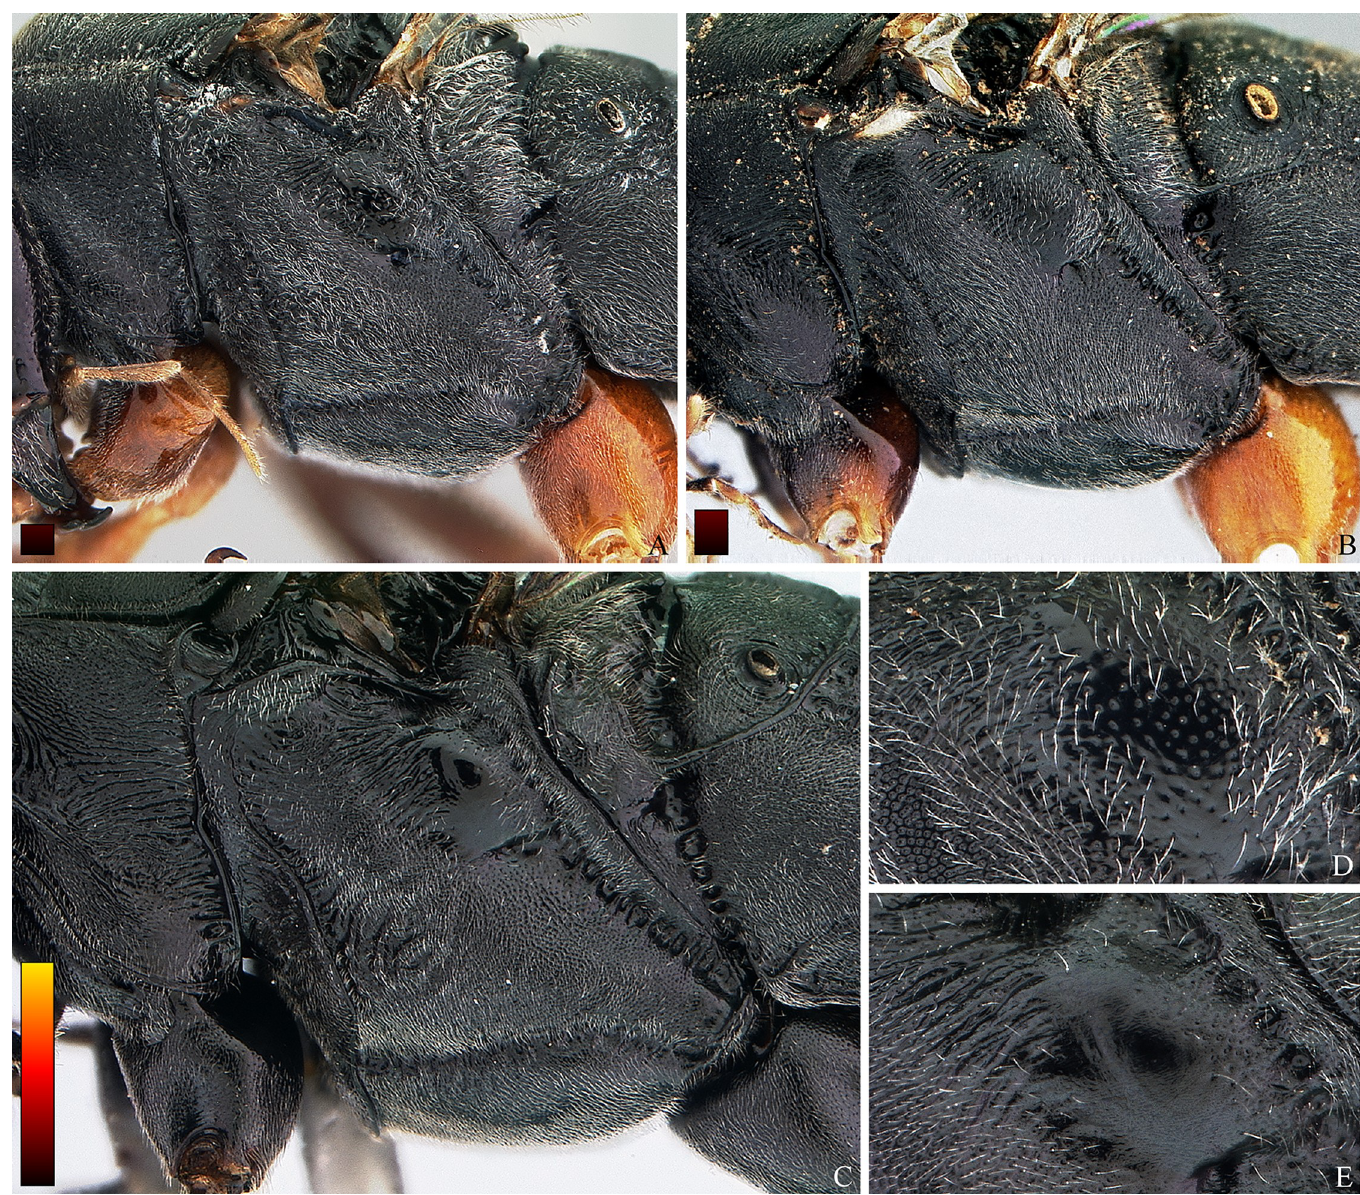
Fig 12. Cryptoxenodon metamorphus sp. nov. from the paratype series. Female mesosoma. (A-C) Mesosoma and propodeum (part), left side. (A) FAS4605, Alt. 75m, Colombia. (B) FAS4601, Alt. 111m, Brazil/AM. (C) FAS331, Alt. 561m, Brazil/ES. (D-E) Speculum on left side. (D) FAS4611, Alt. 36m, Brazil/PA. (E) UFES45548, Alt. 115m, Brazil/BA. Bars are proportional to the